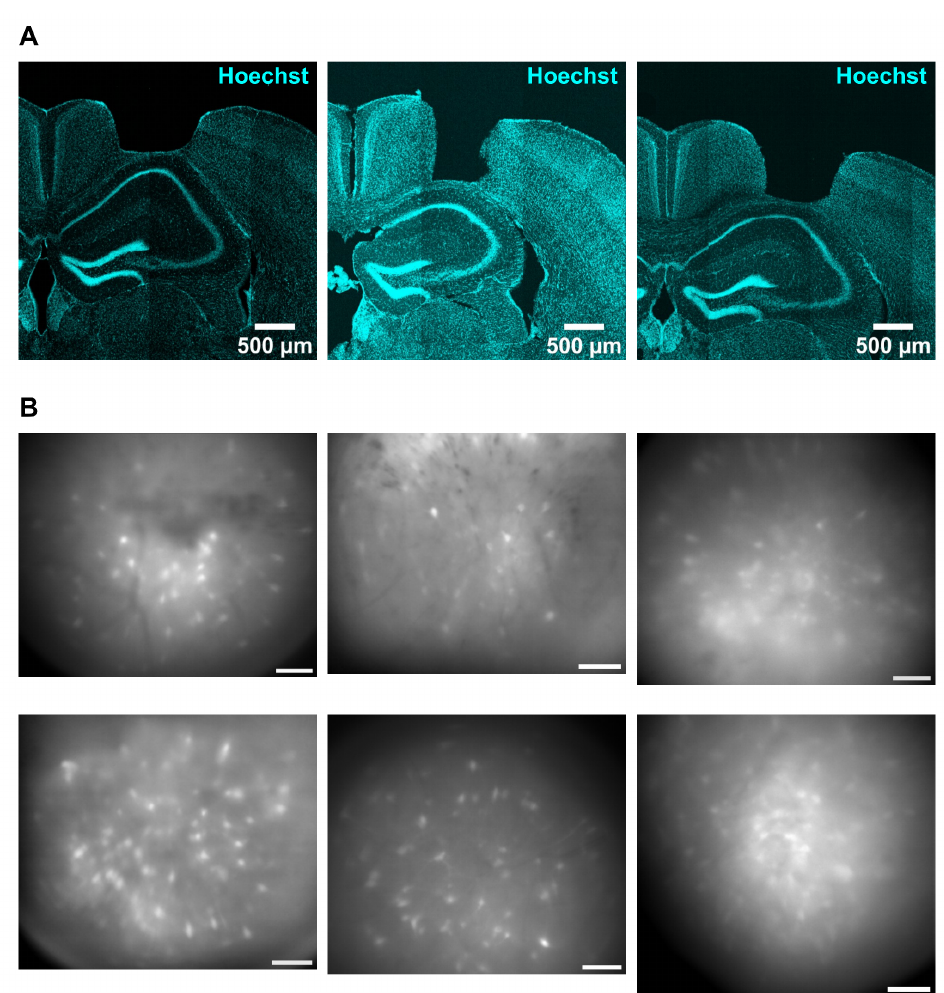
Figure A1. ( A ) Samples of histology sections indicating GRIN lens implantation locations stained with Hoechst. ( B ) Samples of raw NVista HD video screenshots. Scale bars, 100 µm.